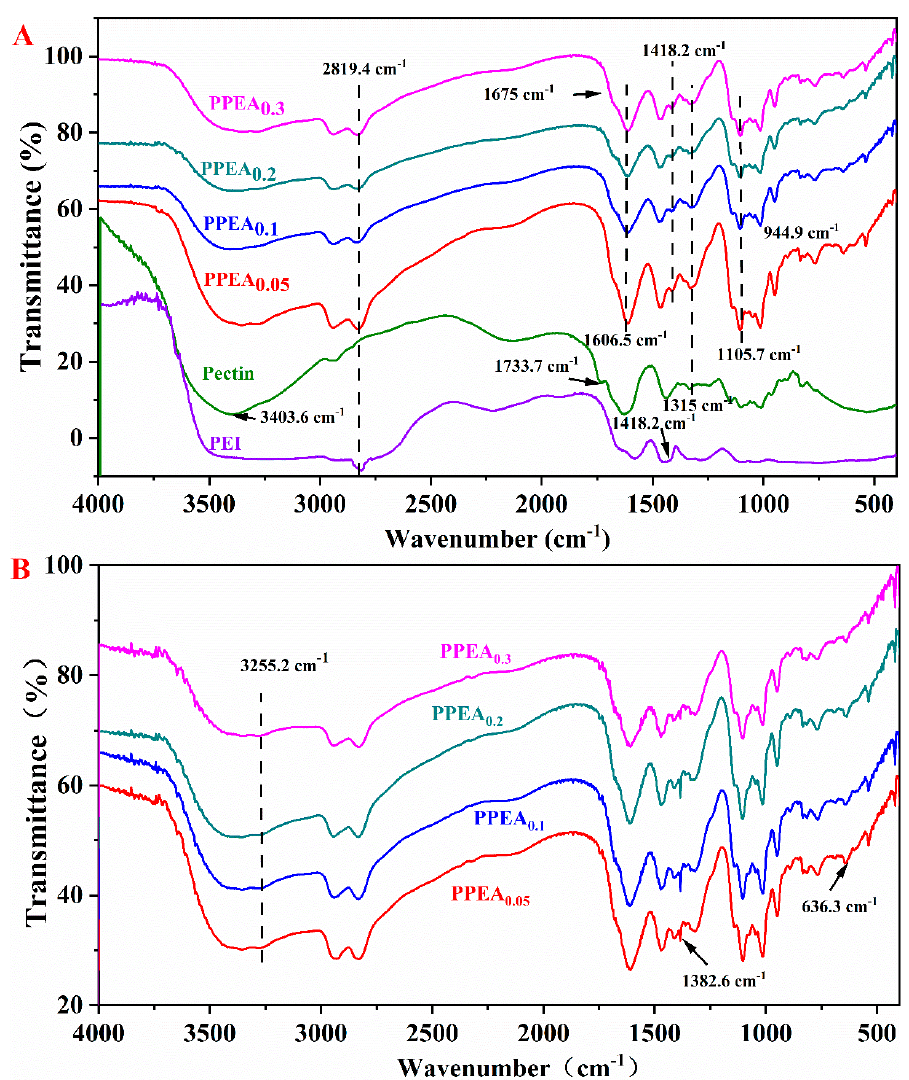
Figure 3. FTIR spectra of the PPEAs before ( A ) and after ( B ) the Pb 2+ adsorption. The FTIR spectra of pectin and PEI are also provided in part A for comparison.